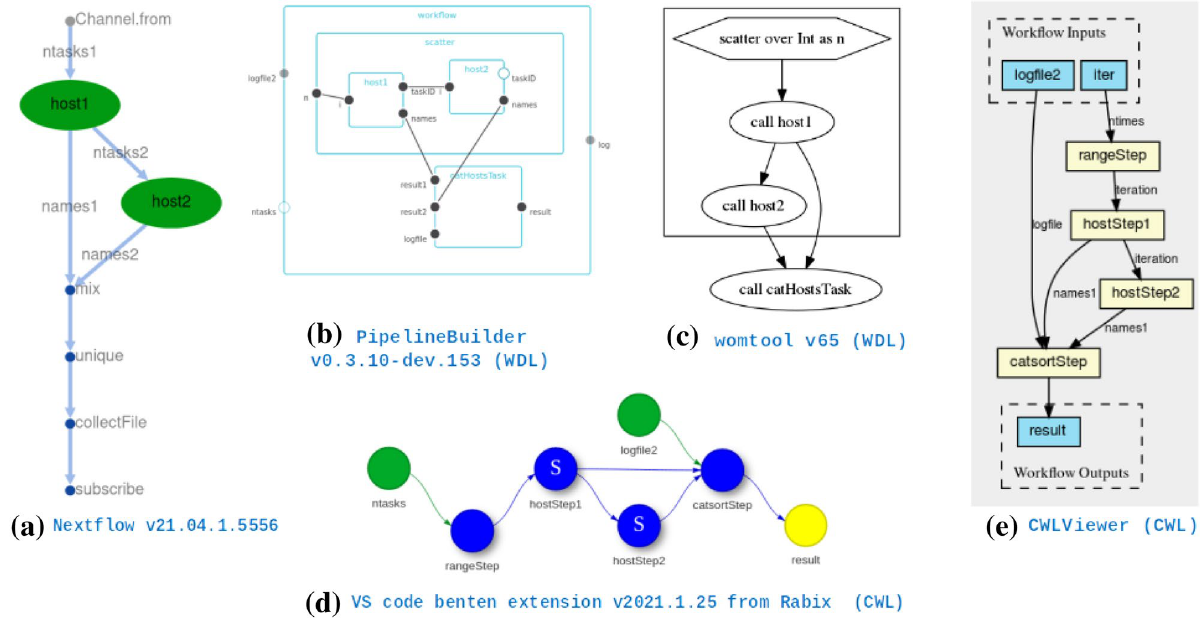
Figure 4. DAGs corresponding to a simple workflow of 2 processes (besides output aggregation) used to assess the scalability of the executors of “Scalability” section, as generated by the most recent version of each executor or utility visualizer of each language in July